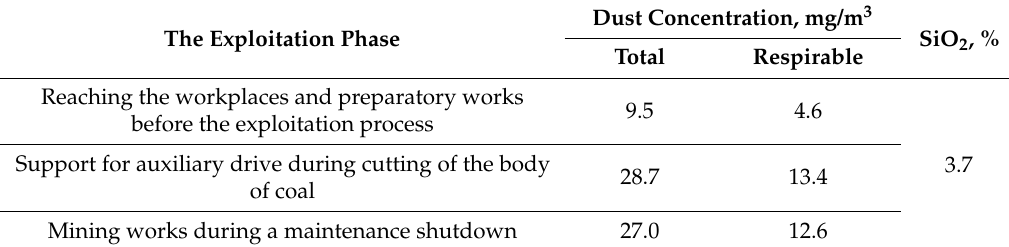
Table 7. The measurement results for the dust levels for selected activities, in the working position the miner working at a distance of 20 to 40 m from the shearer from the side of the air inlet into the